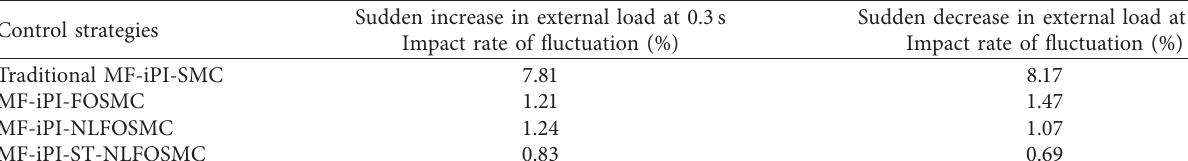
Table 6: The comparison of resistance to external disturbances.